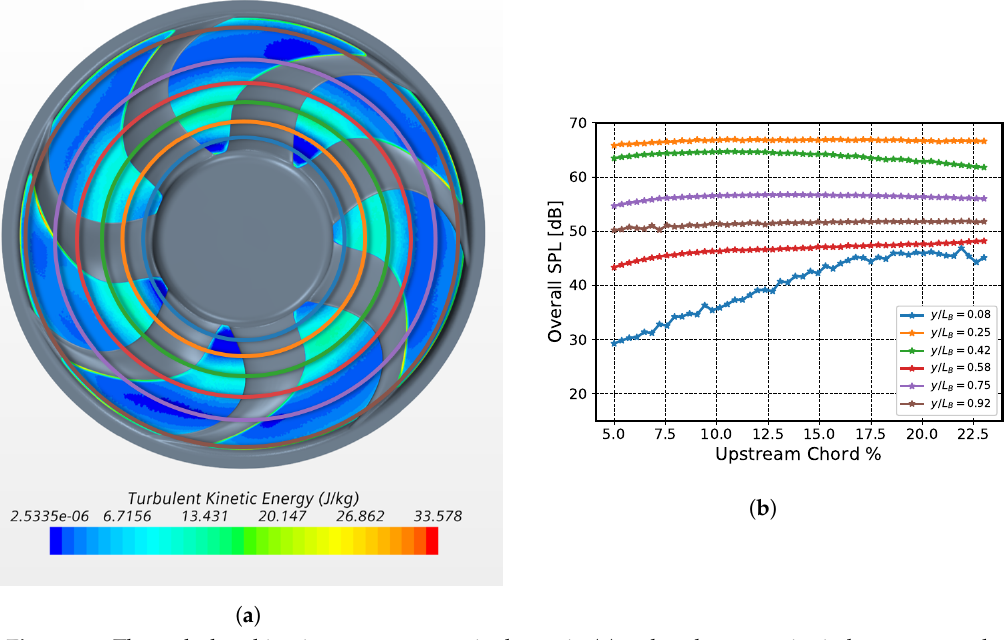
Figure 11. The turbulent kinetic energy content is shown in ( a ); colored concentric circles represent the isoradial locations at which the blade is cut in order to study the overall SPL of the strips shown in ( b ). Here, the overall SPL is depicted against the upstream chord distance from the leading-edge